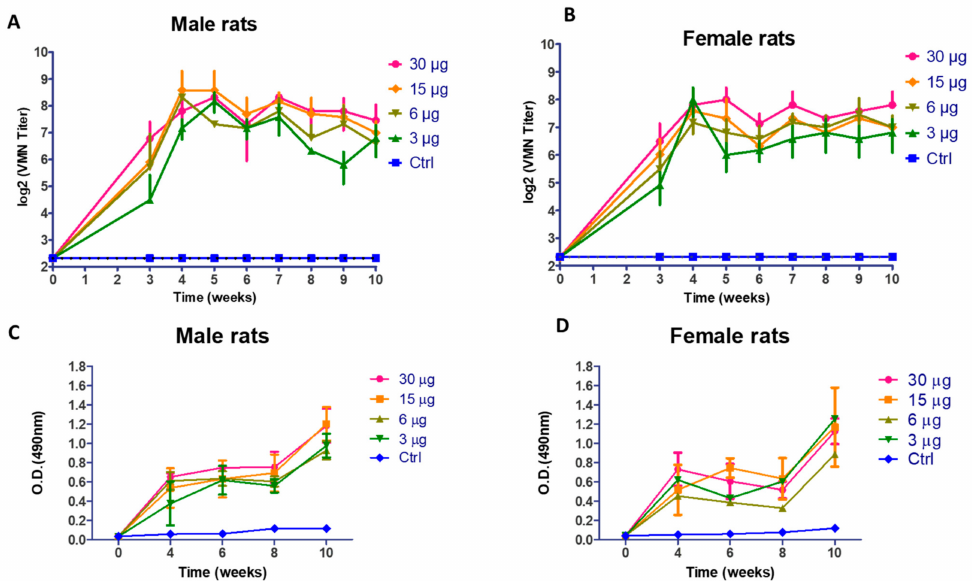
Figure 3. ( A ) Virus microneutralization antibody (VMN) titers in vaccinated male rats; ( B ) Virus microneutralization antibody titers in vaccinated female rats; ( C ) Optical density reading obtained for ELISA of SARS-CoV-2 in vaccinates male rats; ( D ) Optical density reading obtained for ELISA of SARS-CoV-2 in vaccinates female rats. (Ctrl: